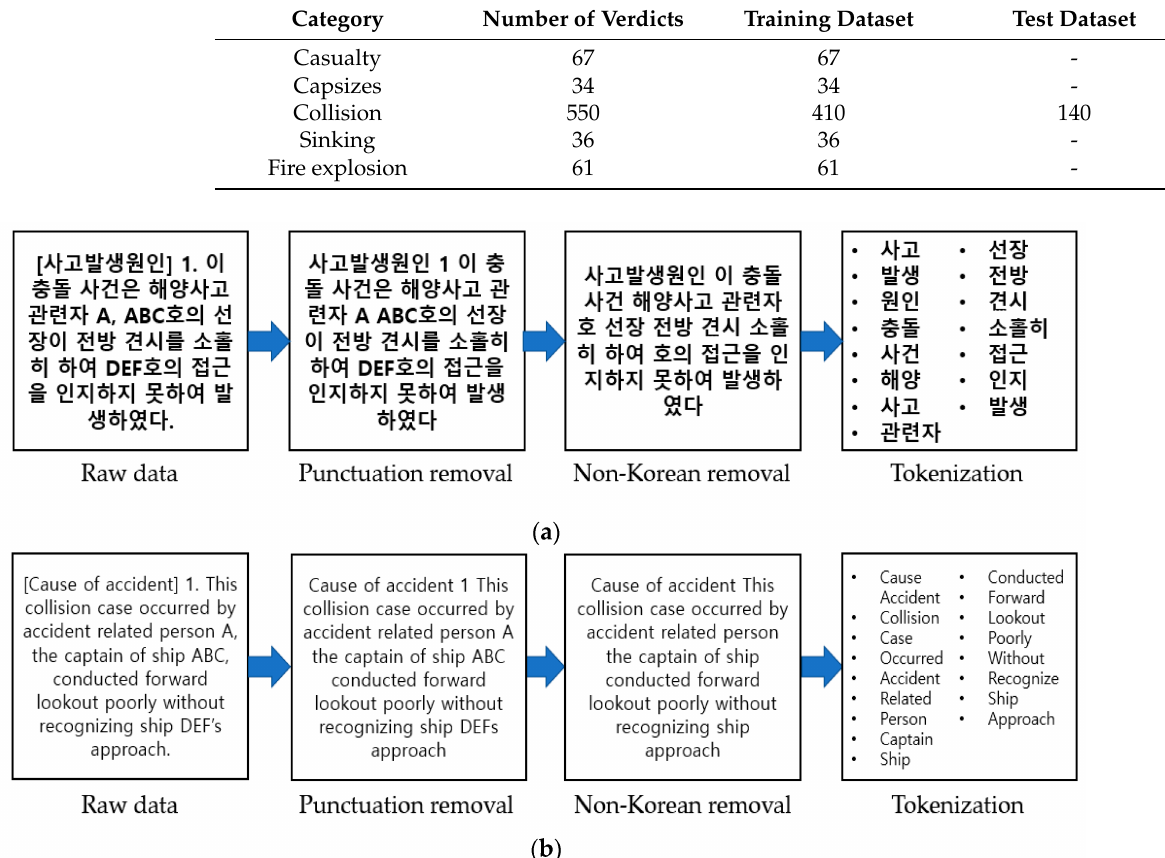
Figure 3. Precise text data-preprocessing procedure: ( a ) Korean text; ( b ) translated text.